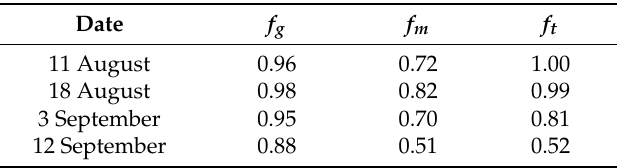
Table 3. Mean values of f g , f m and f t